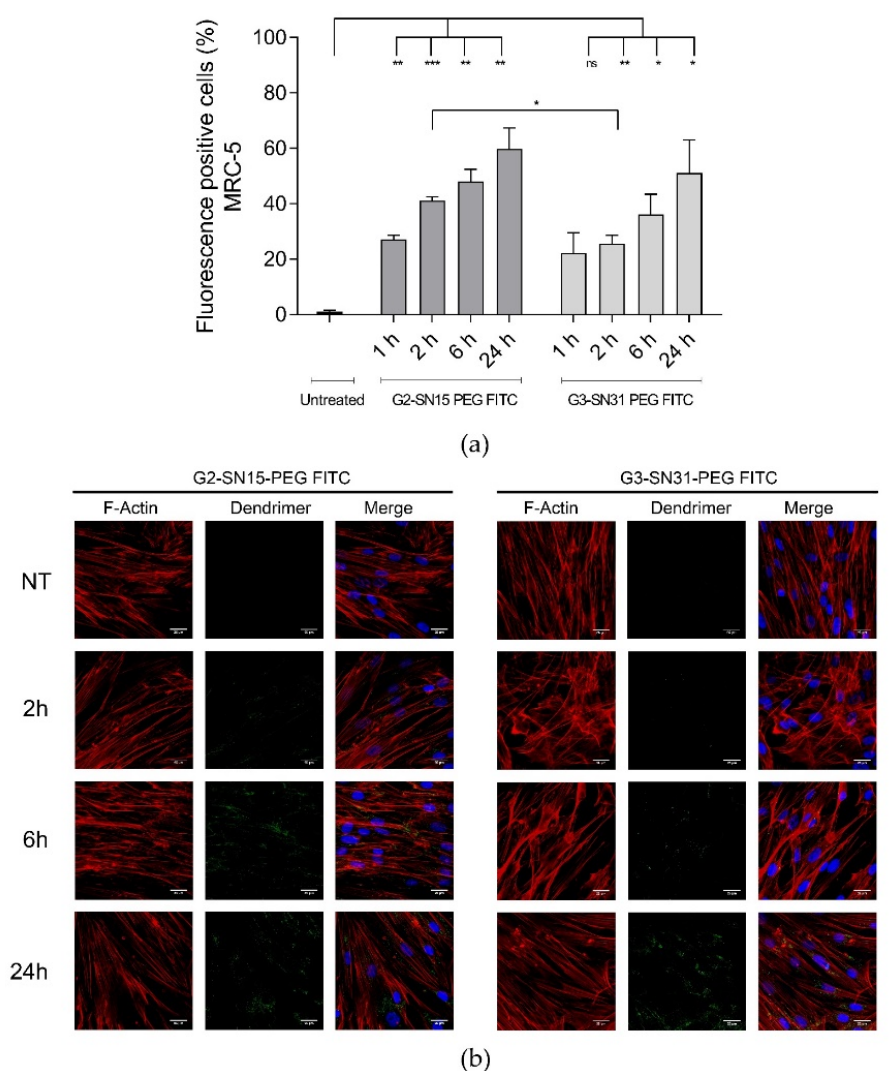
Figure 3. Internalization study of cationic dendrimers into MRC-5 cells. ( a ) Percentage of FITC-positive cells observed by flow cytometry 1 h, 2 h, 6 h and 24 h post-treatment. Data are represented as mean ± SD of two individual experiments. ( b ) Representative confocal images of cells incubated with 1 µM G2-SN15-PEG FITC and 0.5 µM G3-SN31-PEG FITC dendrimers (green) for 2 h, 6 h or 24 h. Phalloidin was used to mark actin filaments (red) and DAPI for nucleus (blue). Scale bars indicate a length of 25 µm. (* p < 0.05; ** p < 0.01; *** p < 0.001; ns: non-significant). DAPI: 4 ′ ,6-diamidino-2-phenylindole dihydrochloride.